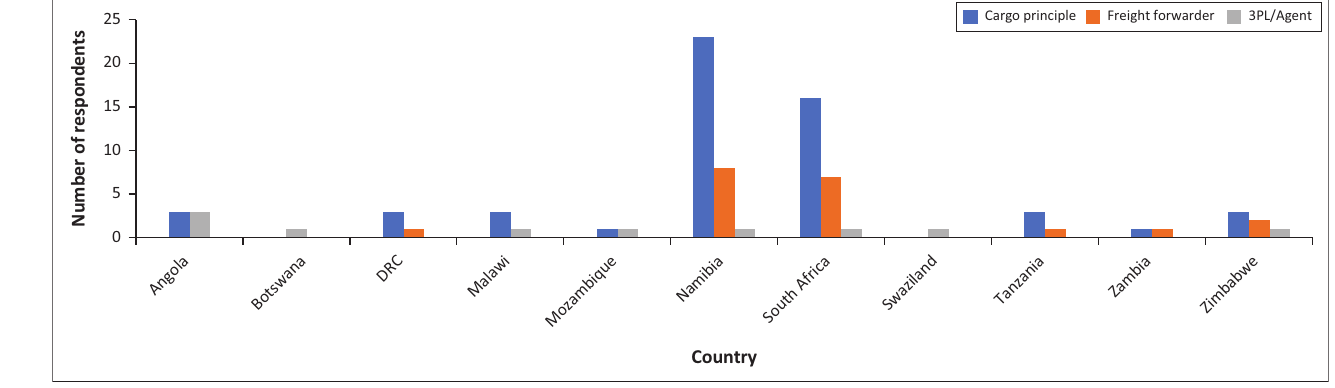
FIGURE 5: Decision-maker by Southern African Development Community